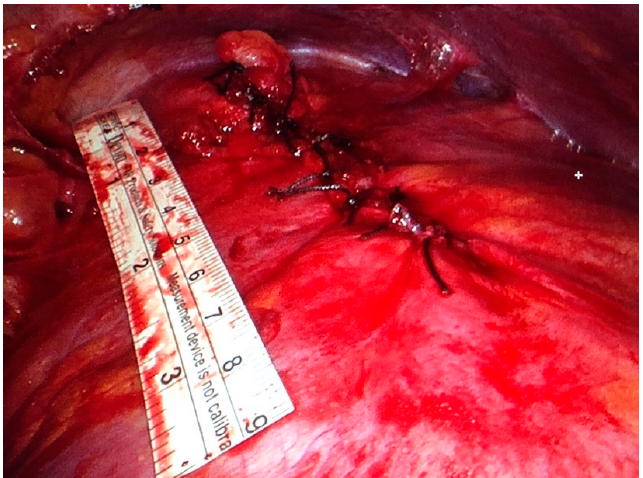
Figure 4. Herniorrhaphy of the diaphragm before the application of the mesh.